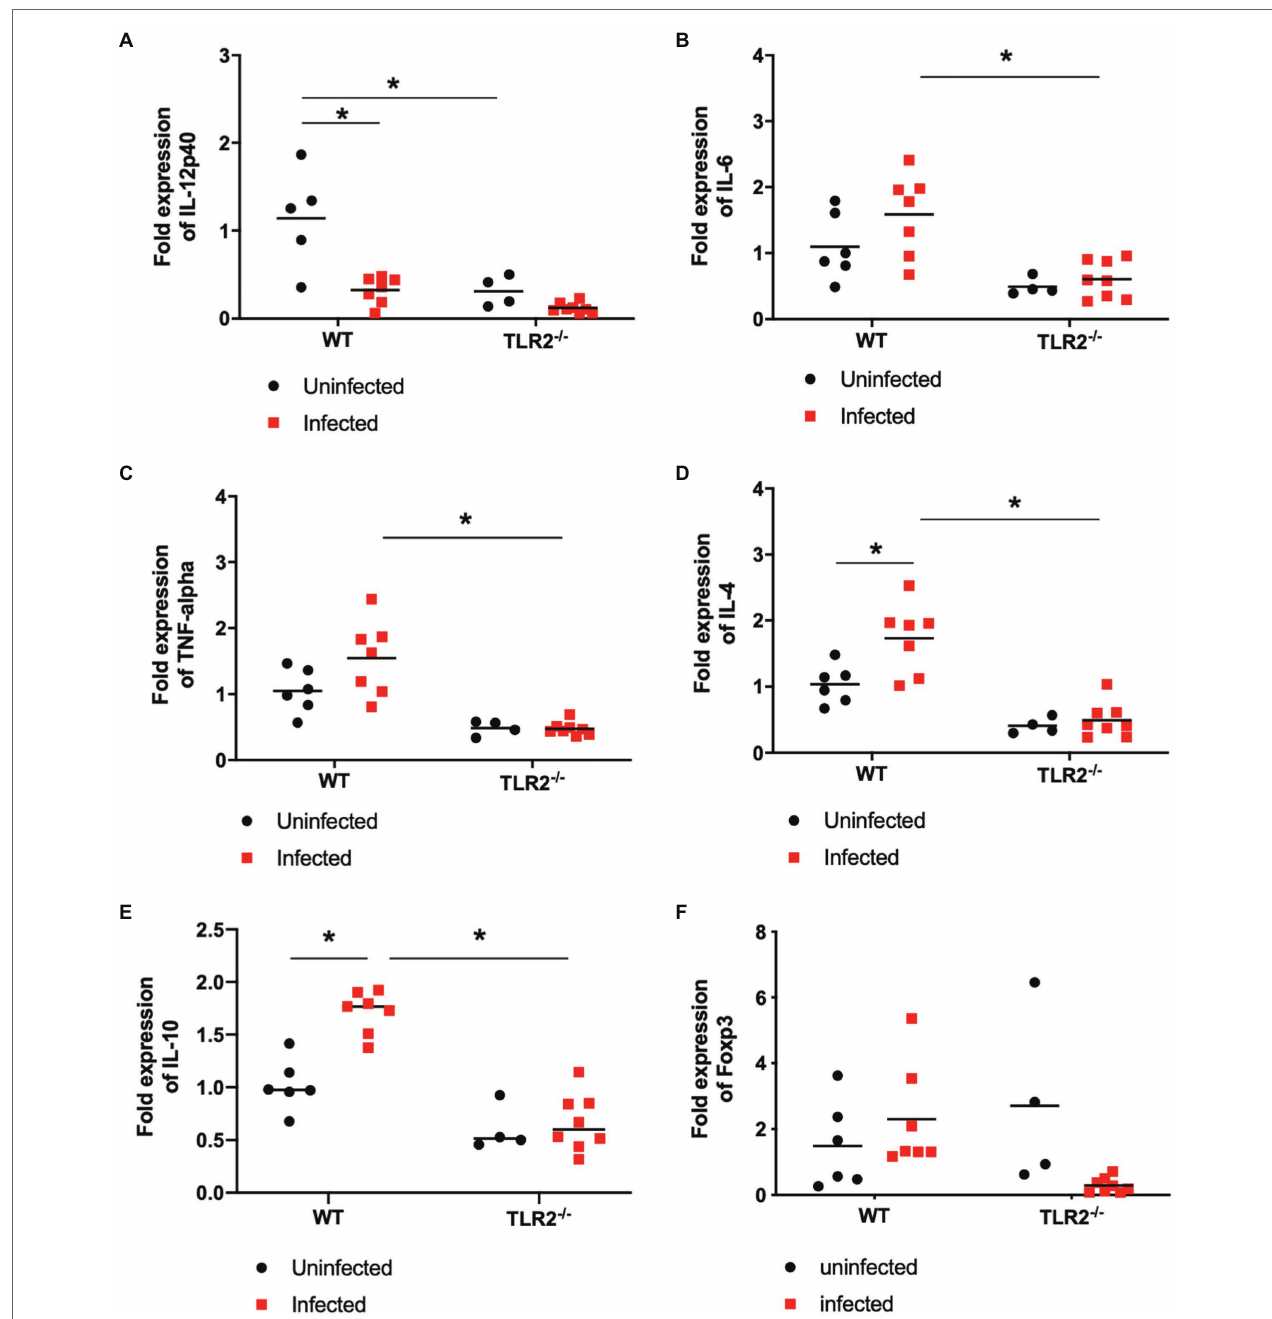
FIGURE 6 | Relative mRNA expression of cytokines in placenta on day 18.5 of pregnancy. Levels of IL-12p40 (A) , IL-6 (B) , TNF-a (C) IL-4 (D) , IL-10 (E) and Foxp3 (F) mRNAs in the placentas of each group were measured with RT PCR. Using synthesized cDNA, the mRNA expression levels of cytokines relative to those in uninfected wild-type (WT) mice were quantified with RT qPCR. Because embryos and placentas collected from one mouse were pooled into one sample, each symbol indicates the data from a single mouse. Uninfected WT mice ( n = 6), infected WT mice ( n = 7), uninfected TLR2 − / − mice ( n = 4), infected TLR2 − / − mice ( n = 8). The horizontal lines show the mean values for each group. Data were analyzed with two-way ANOVA followed by the Tukey–Kramer multiple-comparison test. * p <